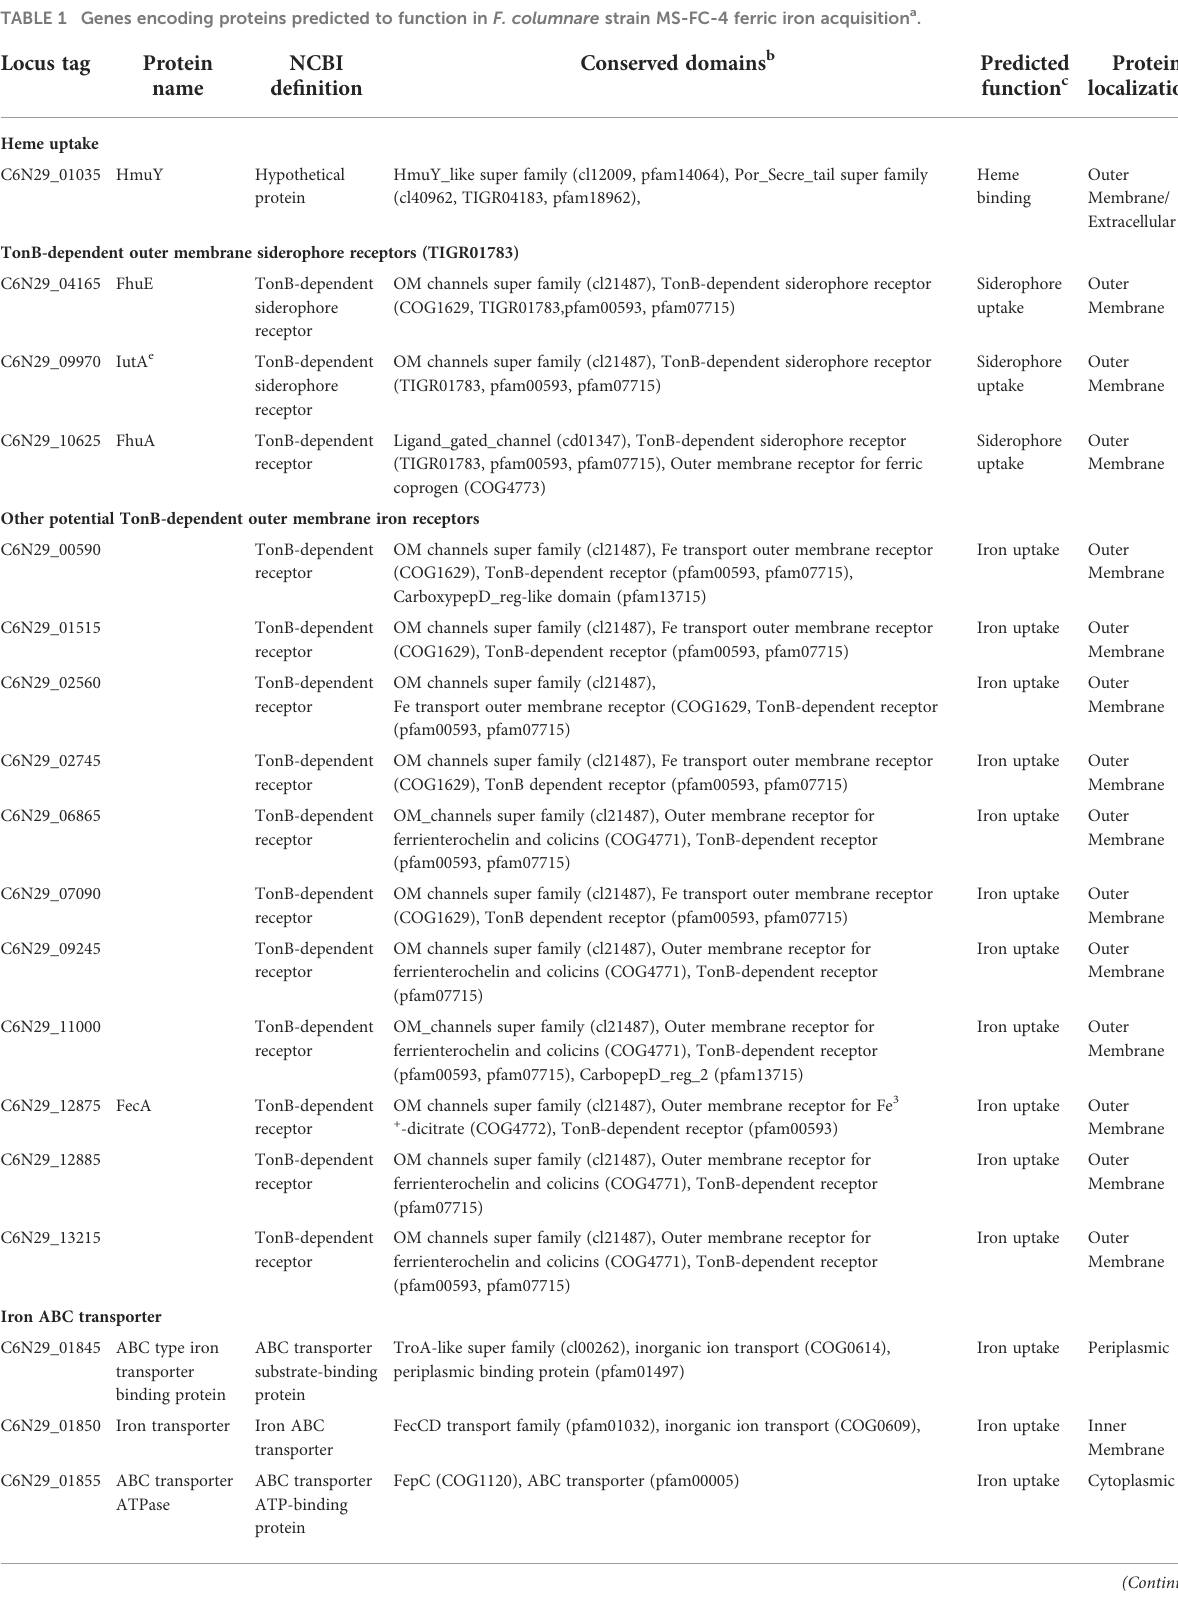
TABLE 1 Genes encoding proteins predicted to function in F. columnare strain MS-FC-4 ferric iron acquisition a